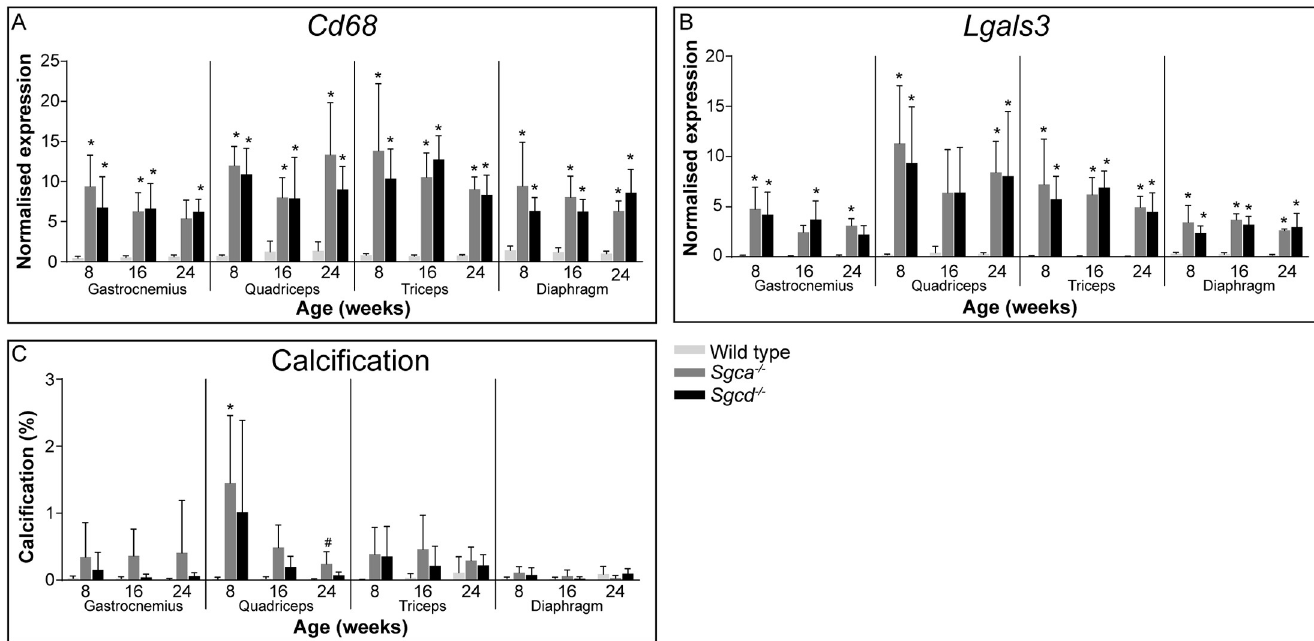
Fig 5. Inflammation and calcification in Sgca -/- and Sgcd -/- males. (A and B) Gene expression of Cd68 (A) and Lgals3 (B). (C) Quantification of calcification by the Alizarin Red staining. N = 5-6 male mice per group. � p < 0.05 vs age-matched wild type mice. # p < 0.05 over time (same genotype).